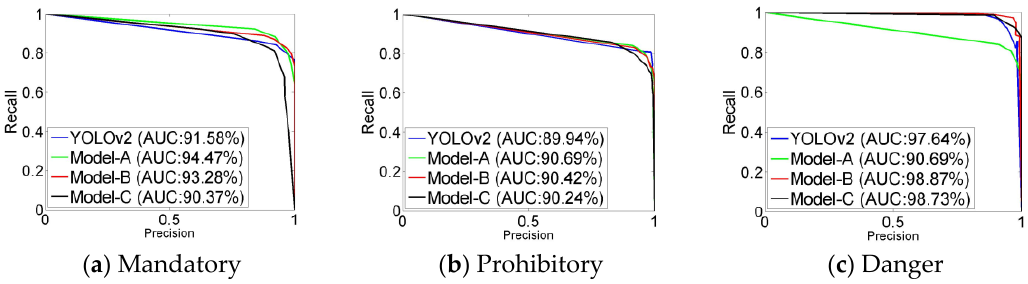
Figure 6. The precision-recall curves of the three super categories.